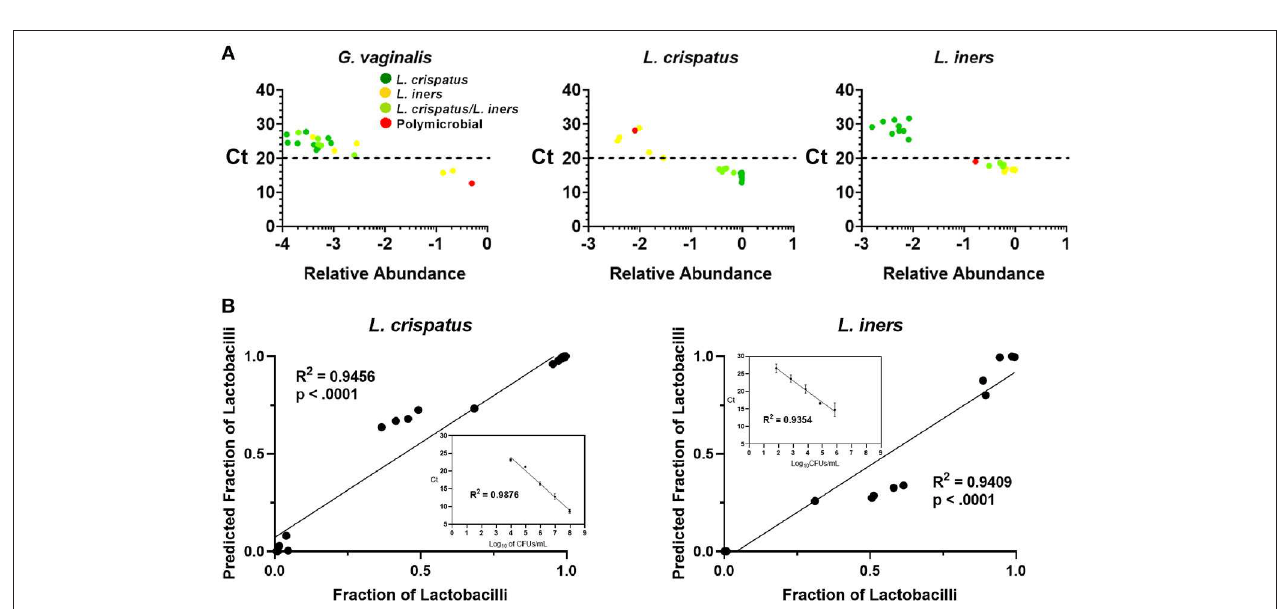
FIGURE 3 | (A) Individual CVS samples according to their relative species abundance, as obtained from 16S rDNA sequencing, and their Ct determined by qPCR using species specific primers for G. vaginalis , L. crispatus , and L. iners . Individual data points are color coded for each group based on sequencing. Dashed lines indicate Ct = 20, our suggested threshold. (B) Individual CVS samples according to the predicted fraction of L. crispatus or L. iners relative to the combined lactobacilli concentrations determined by qPCR compared to that obtained from the 16S rDNA sequencing. Insets show the standard curve used to estimate the concentration of the indicated species and calculate the predicted fraction by